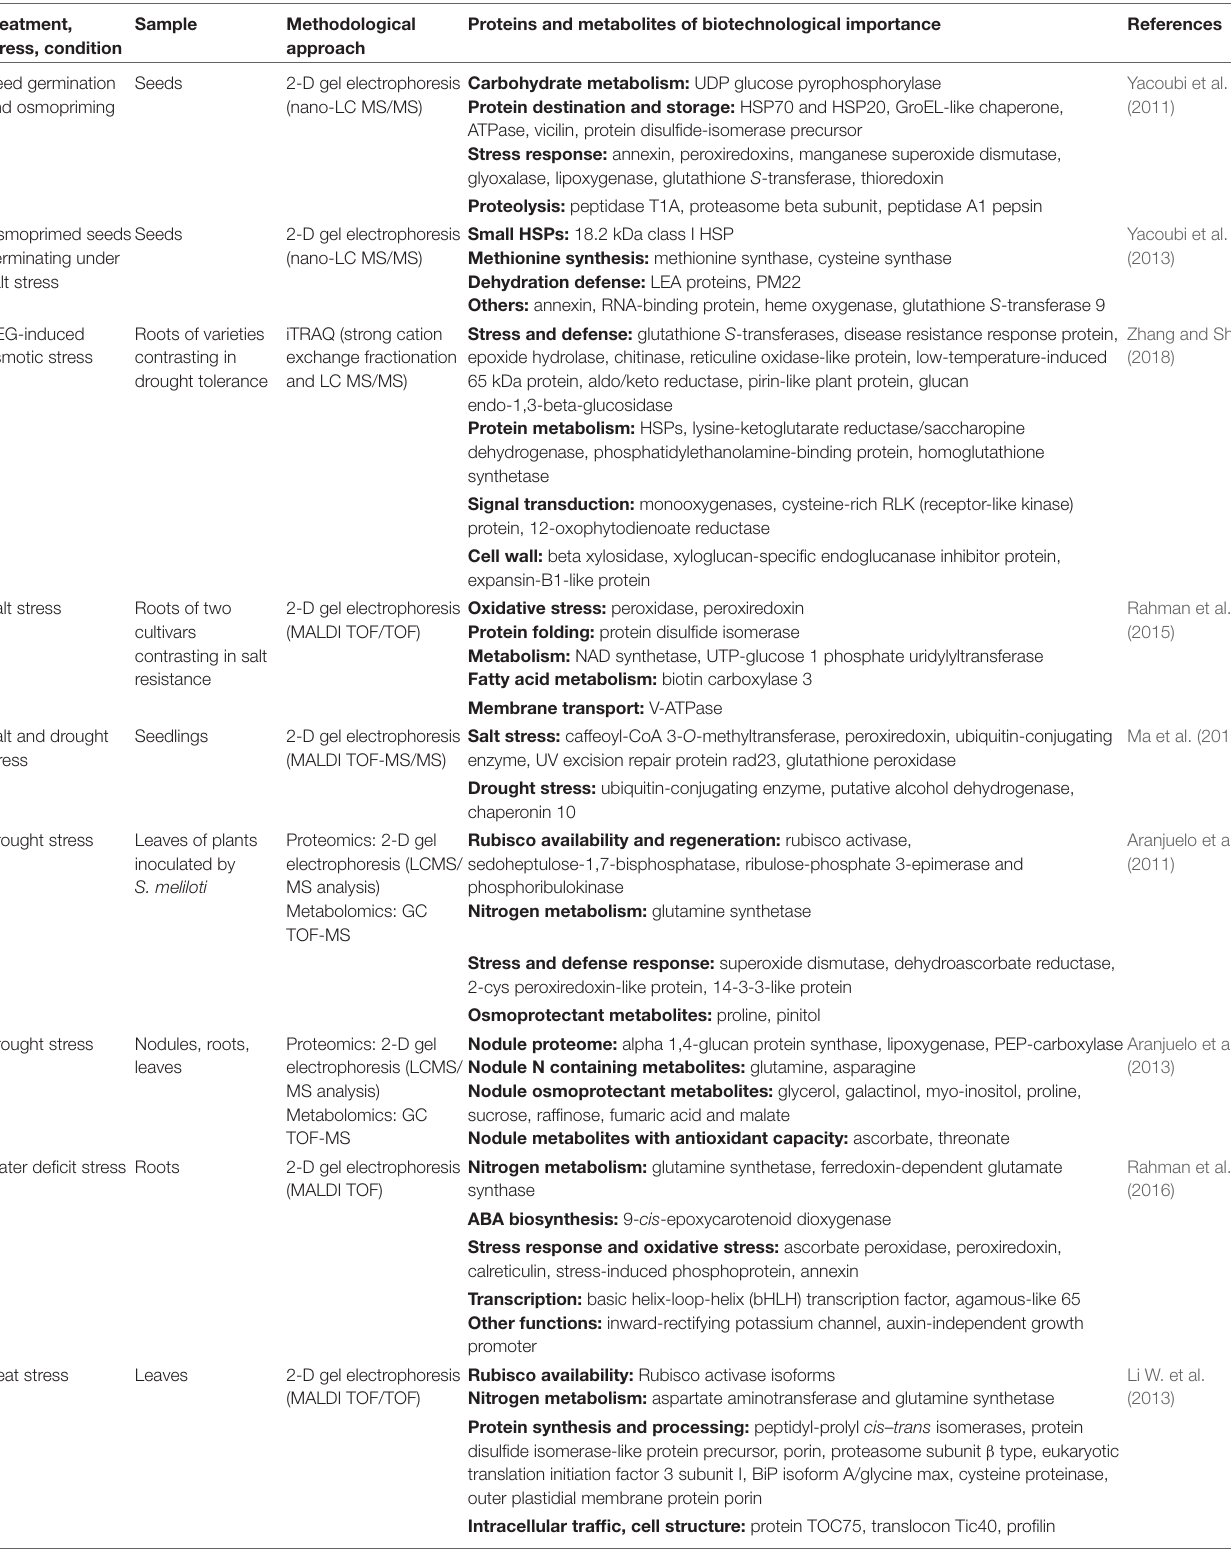
TABLE 1 | Overview of proteins and metabolites important for biotechnological improvement of alfalfa as revealed by proteomic and metabolomic studies. Treatment, stress, condition